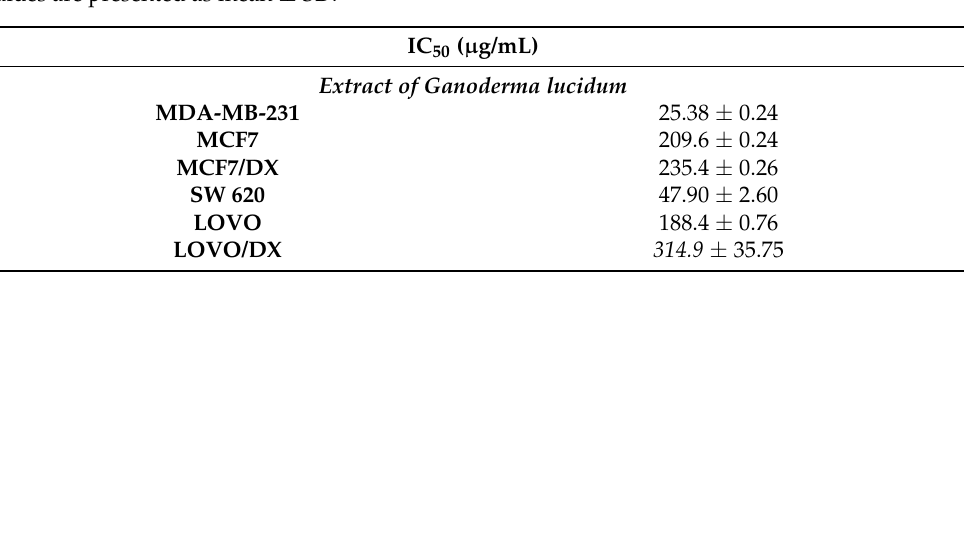
Table 4. Inhibition concentrations (IC 50 ; µ g/mL) of Ganoderma lucidum against six cancer cell lines. Values are presented as mean ±